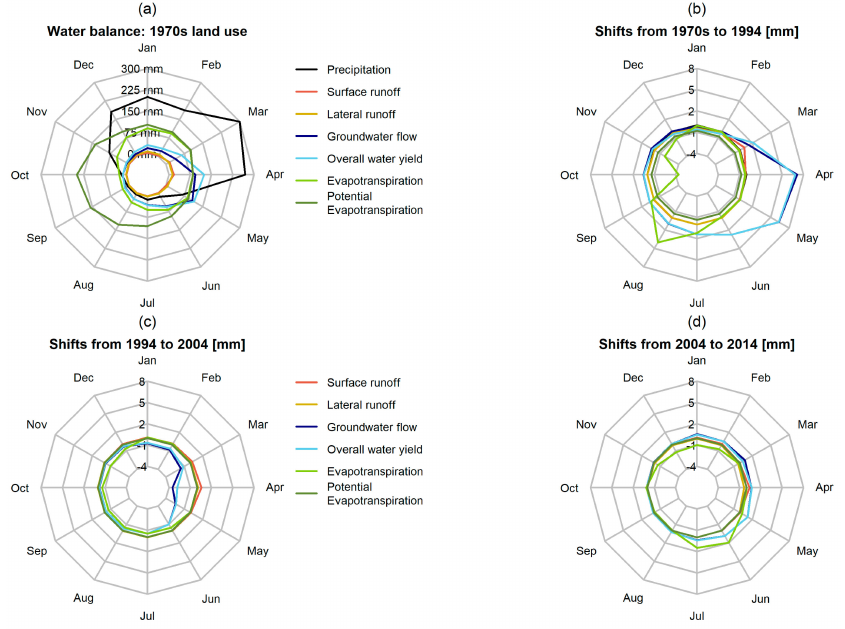
Figure 13. Shifts in water balance components (in mm) for the entire catchment on a monthly time scale running the model with four different land use maps. ( a ) Shows the water balance of the 1970s land use map run, ( b ) displays a comparison of the 1970s map with the land use of 1994, ( c ) the changes from 1994 to 2004, and ( d ) illustrates the shifts from 2004 to 2014. All inputs except for land use maps are not modified.